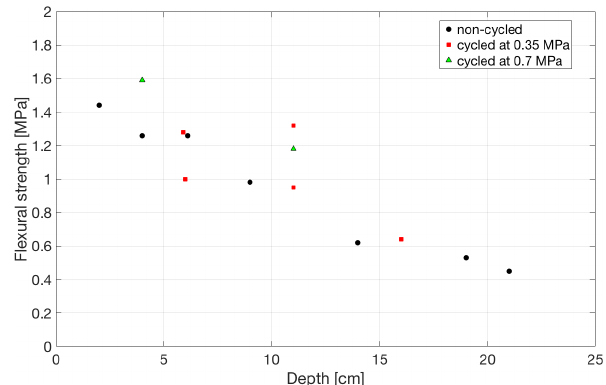
Figure 9. Flexural strength of freshwater ice and saline ice of lower (3.0 ± 0.9ppt) and of higher (5.9 ± 0.6ppt) salinity as a function of reverse-cycled stress amplitude. Freshwater ice laboratory and lake data are taken from Murdza et al. (2020b, 2021). Red five- pointed stars and green squares represent tests performed on saline ice of lower and higher salinities, respectively, at 0.1mms − 1 and − 10 ◦ C. During all depicted tests the ice did not fail during cycling and was broken by applying one unidirectional displacement until failure occurred.